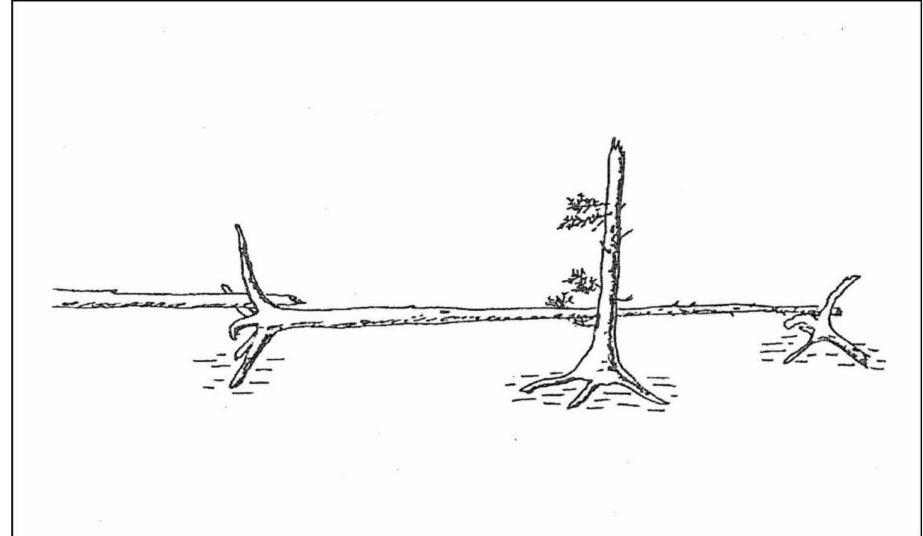
Figure 3. A schematic of how the fence was built using wood available to the builders from the surrounding area (after